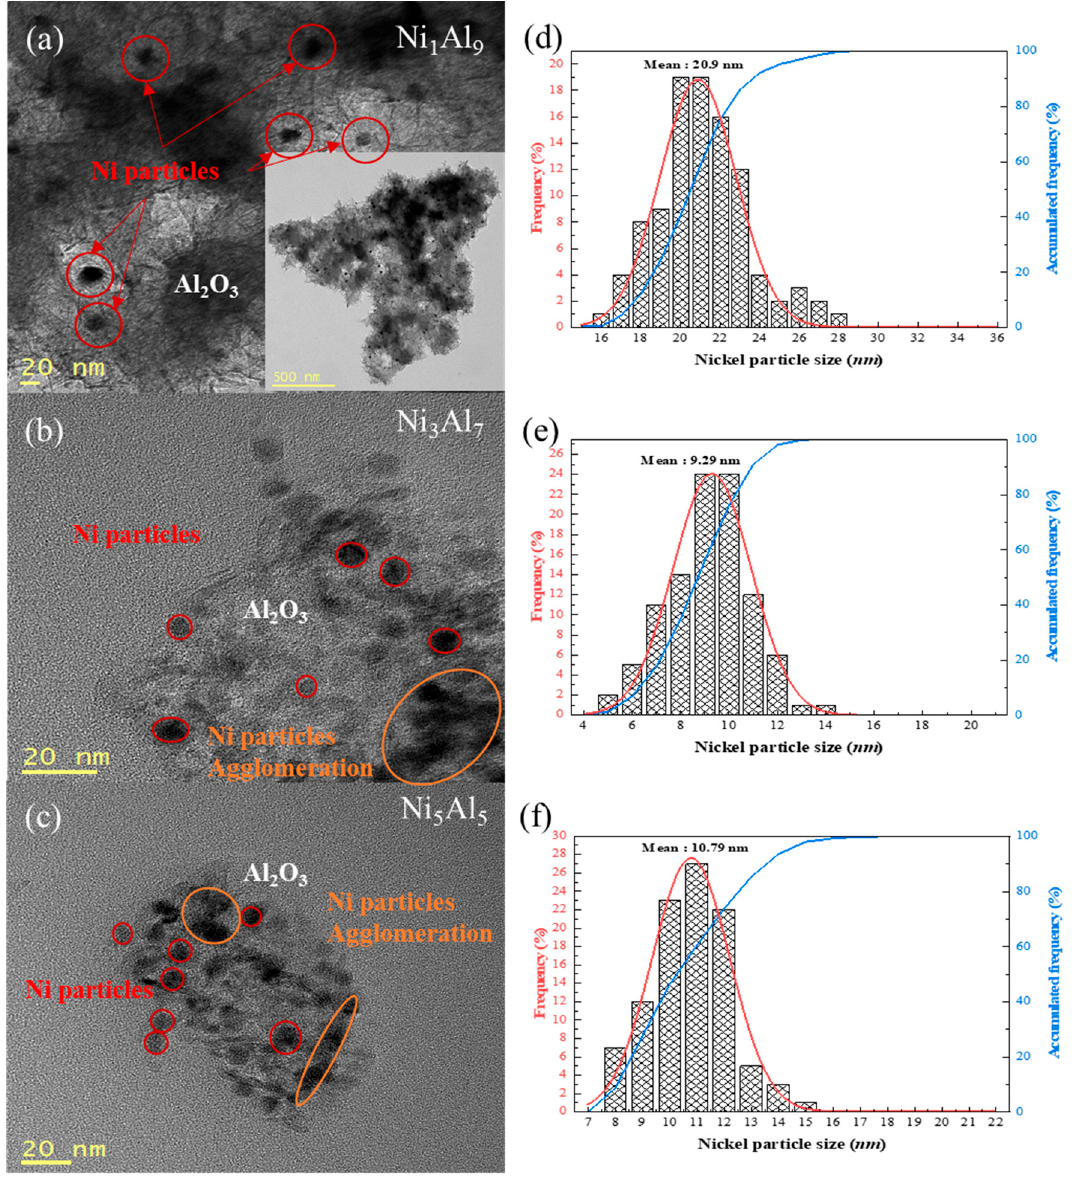
Figure 3. Respective transmission electron micrographs and Ni particle size distributions of the reduced NiAl 2 O 4 catalysts with various Ni/Al ratios: ( a , d ) Ni 1 Al 9 , ( b , e ) Ni 3 Al 7, and ( c , f ) Ni 5 Al 5 .